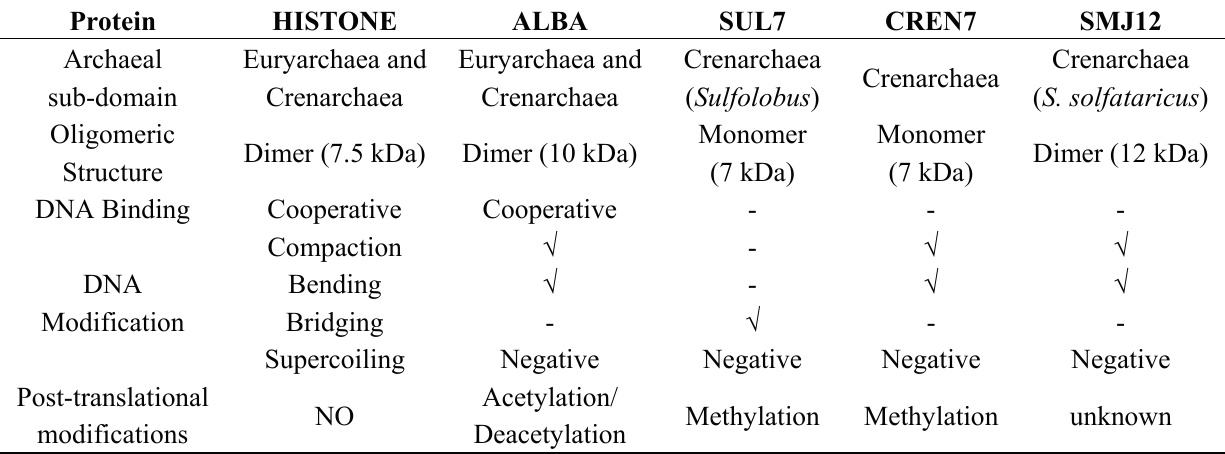
Table 1. Distribution, main structural features and activities of architectural proteins of hyperthermophilic archaea. “ √ ” and “-” indicate the presence or absence, respectively, of a particular activity or